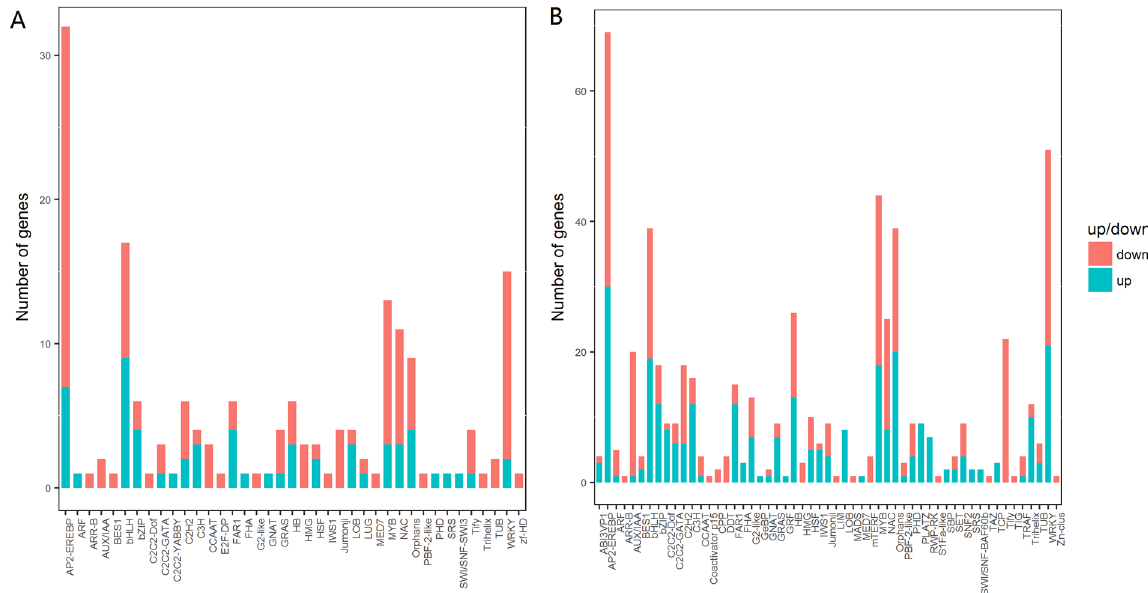
Figure 5. Class-wise counts of transcription factors identified in DEGs under waterlogging. ( A ) TFs (up- and down-regulated) were found in 3 h waterlogging. ( B ) TFs (up- and down-regulated) were found in 27 h